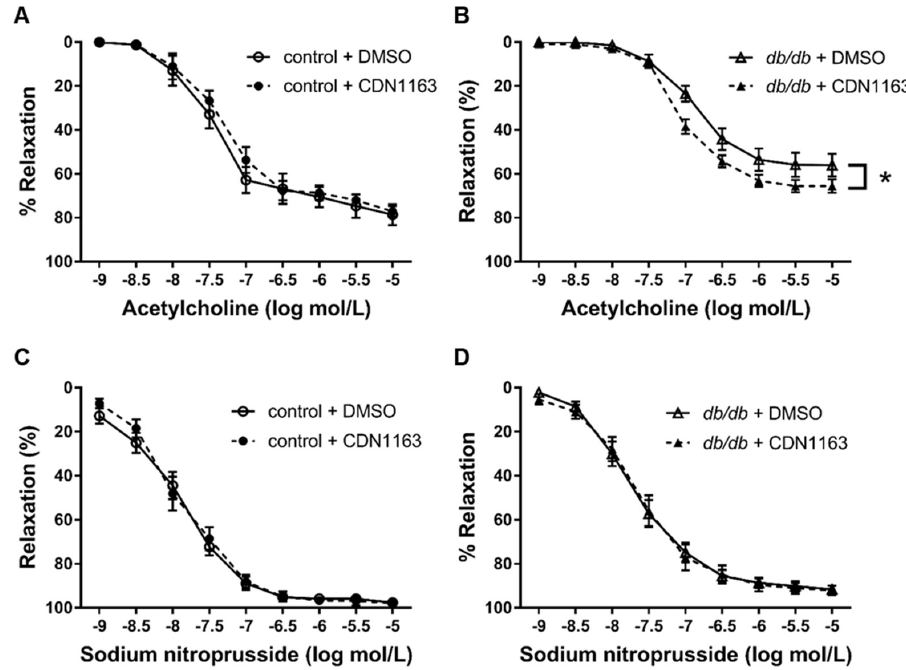
Figure 7. CDN1163 increases endothelium-dependent function in db / db mice in ex vivo experiments. All experiments were conducted on the condition that either DMSO (5 µ L) or CDN1163 (1 µ M, 5 µ L) was added to the bath for 15 min before L-phenylephrine precontraction. ( A , B ) Vascular relaxation of aortic rings isolated from control mice ( A ) (n = 8 for each group) or db / db mice ( B ) (n = 12 for each group) with ACh. ( C , D ) Vascular relaxation of aortic rings isolated from control mice ( C ) (n = 8 for each group) or db / db mice ( D ) (n = 12 for each group) with SNP. Results of relaxation are expressed as percentage changes in the steady-state level of contraction with 10 − 6.5 mol/L L-phenylephrine. Error bars represent SEM. * p < 0.05 vs. Db+DMSO. CDN, CDN1163; Ctrl, control mice; Db, db / db mice; veh, vehicle; SNP, sodium nitroprusside.